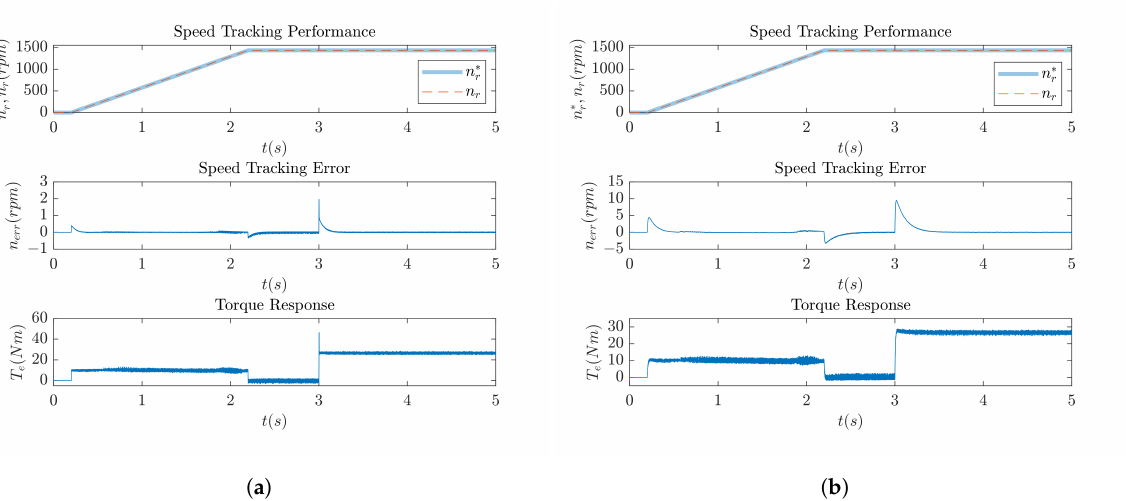
Figure 12. System performance. ( a ) With original optimized parameters. ( b ) With reduced K Pf and K If